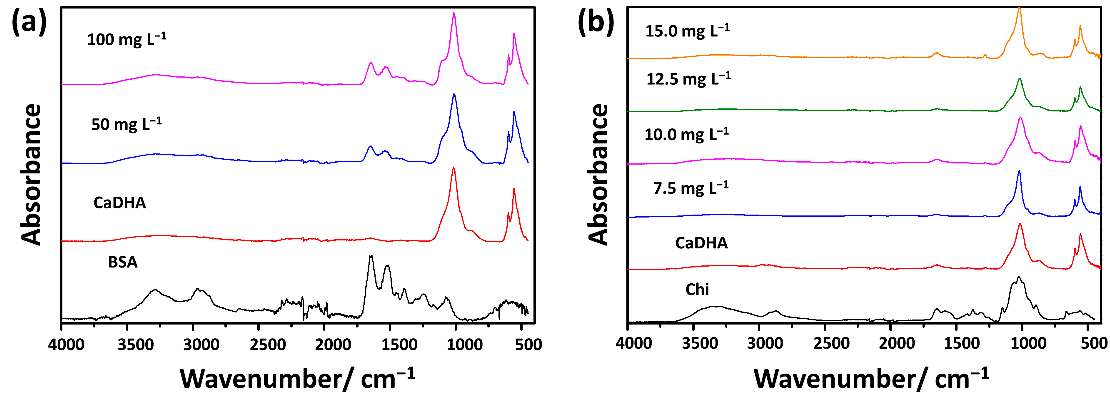
Figure 4. FTIR spectra of the precipitates obtained in the control system (CaDHA) and the presence of different concentrations of ( a ) bovine serum albumin (BSA) after 60 min and ( b ) chitosan (Chi) after 120 min. c (CaCl 2 ) = c (Na 2 HPO 4 ) = 4 × 10 − 3 mol dm − 3 , pH init = 7.4, ϑ = (25 ± 0.1) °C.